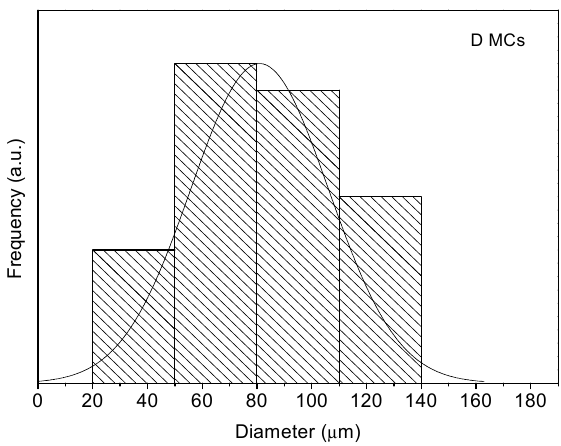
Figure 7. Size distribution of D MCs.